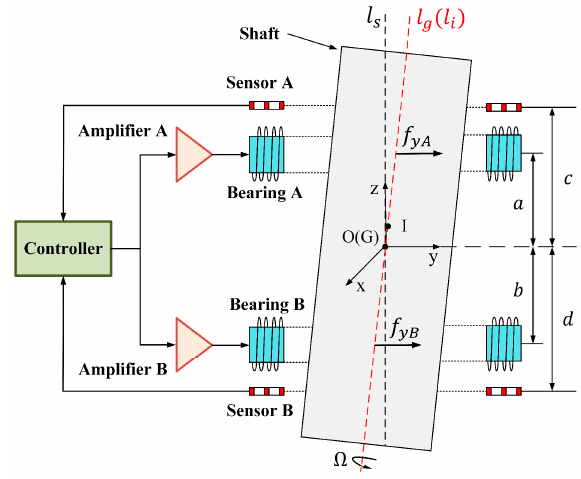
Figure 1. Diagram of the structure of the radial 4-dof AMB system.